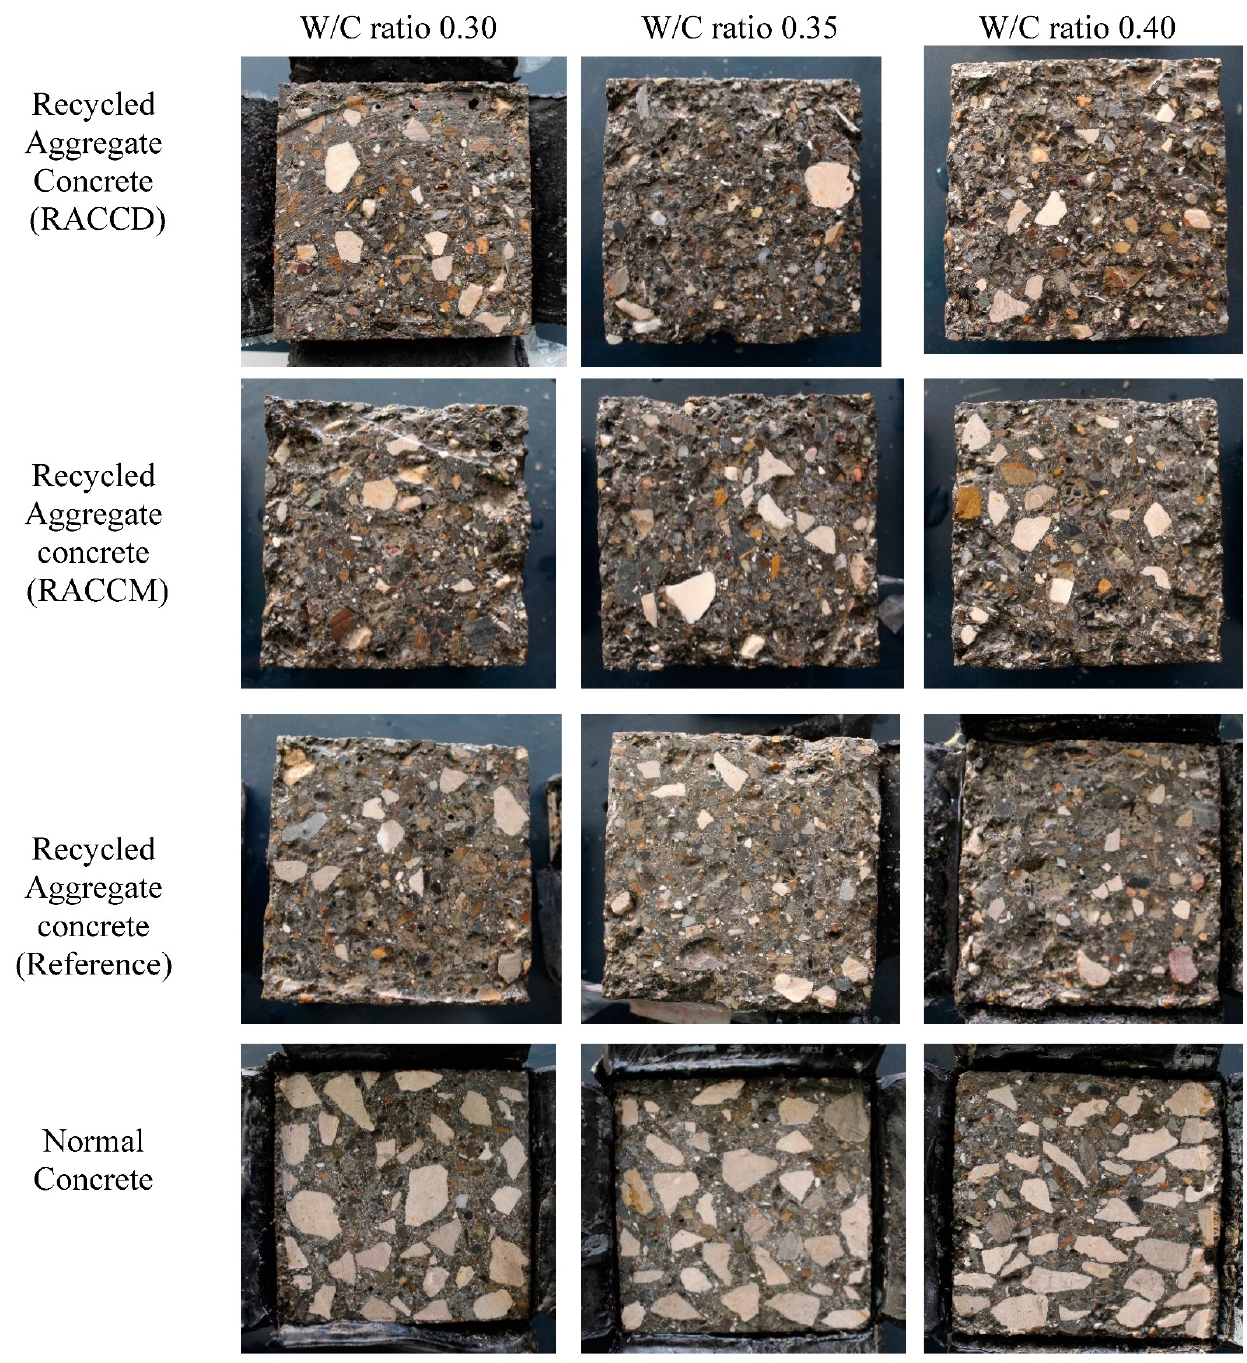
Figure 7. Surface appearances of RAC Treatment method (RACCD), RAC Treatment method (RACCM), RAC (Reference), Normal Concrete specimens after exposure to 28 cycles of freezing and thawing in the presence of deicer salt .